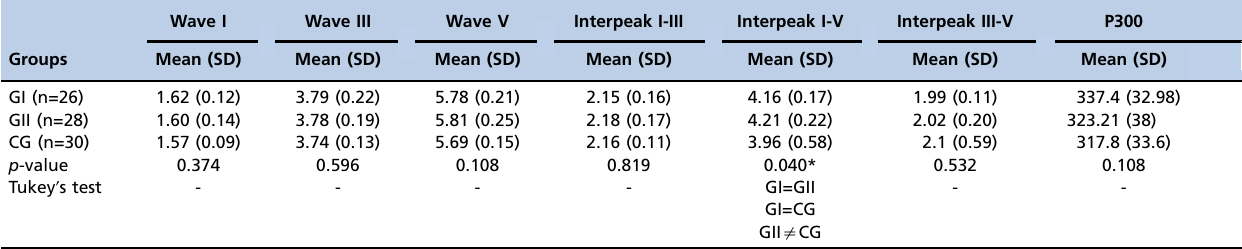
Table 4 - Mean and standard deviation (in ms) of waves I, III, and V; interpeak intervals I-III, III-V, and I-V; and P300 wave latencies of both the ears, by group. Wave I